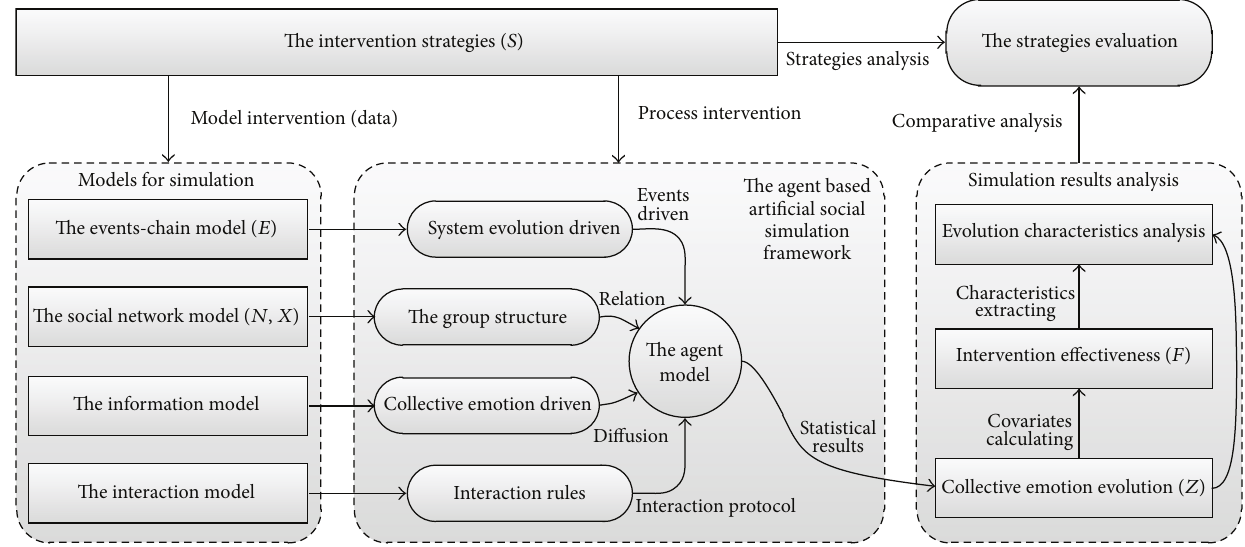
Figure 1: The research framework of collective emotion simulation and strategy